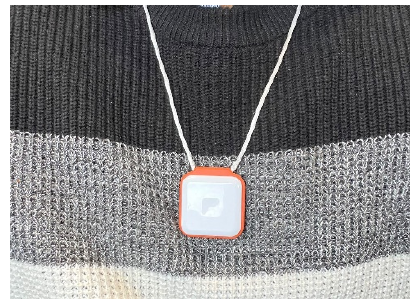
Figure 3. PAMSys TM pendant .